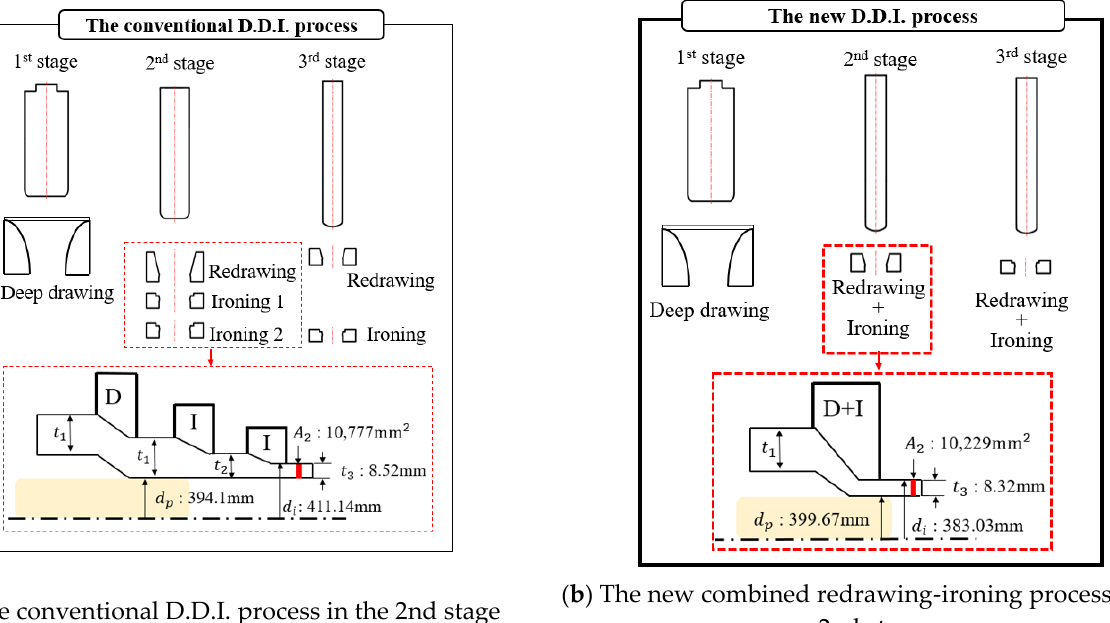
Figure 15. Comparison of two processes in the 2nd stage.